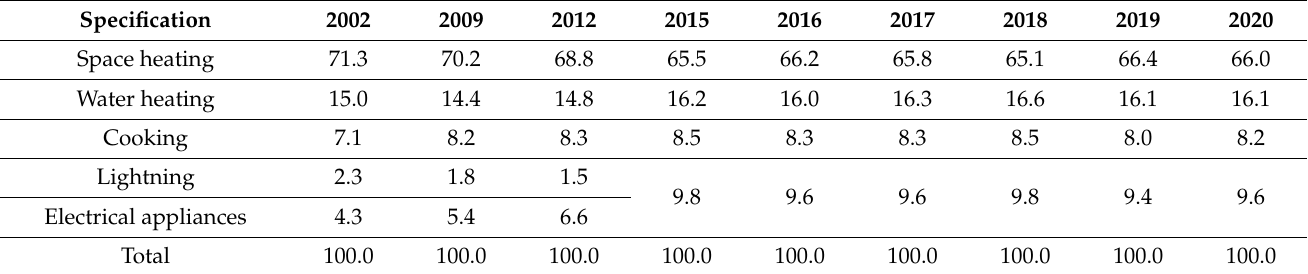
Table 1. Structure of energy consumption in households by end use (%).